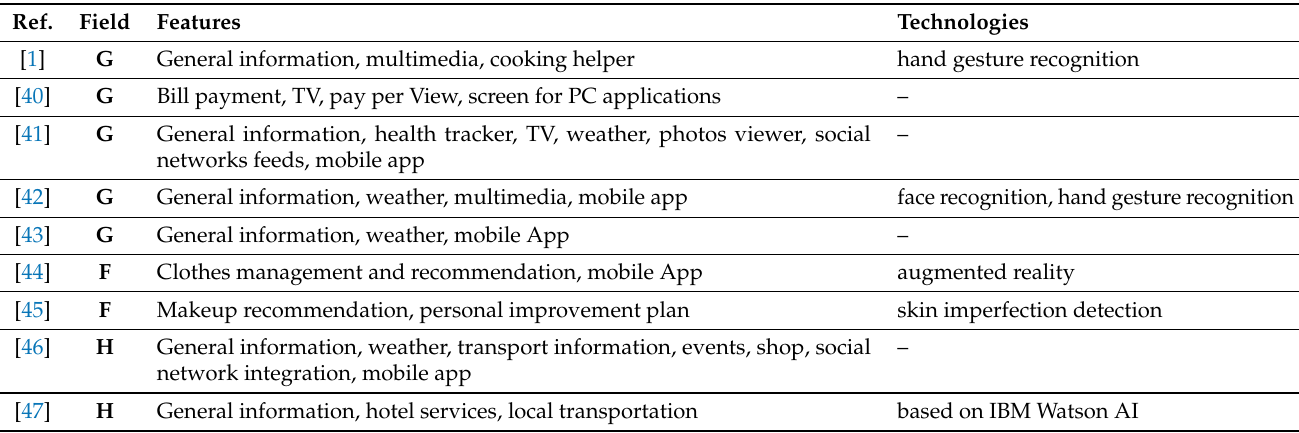
Table 2. A summary table for commercial smart mirrors. Field indicates intended use of mirror: (G)eneral, (F)ashion, and